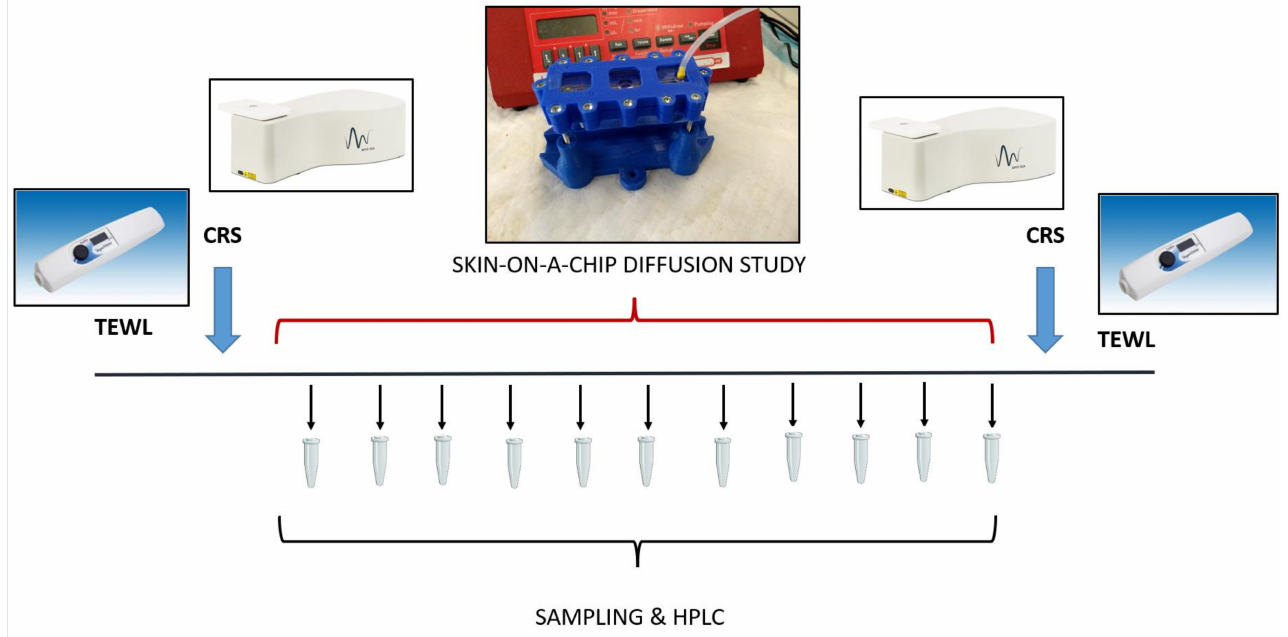
Figure 1. The experimental design for analysis of skin barrier function, skin composition and transdermal penetration of topical model drugs. TEWL: Transepidermal Water Loss; CRS: Confocal Raman Spectroscopy; HPLC: High-Performance Liquid Chromatography. The barrier function was measured at the beginning and at the end of the experiments on the skin and skin substitutes. Then the skin composition was analyzed by CRS, and this was followed by a skin-on-a chip diffusion study. The microfluidic samples were collected for 5 h every 30 min. Then, the accumulation of the test drugs was tested in the skin again by